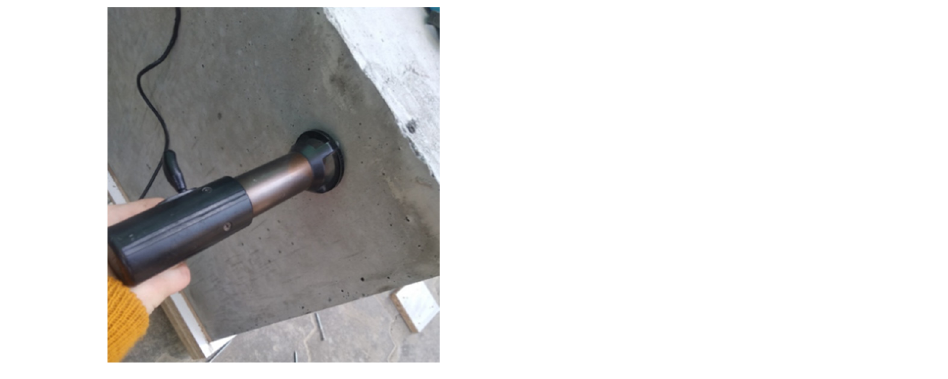
Figure 4. Determination of the strength of concrete in boxes obtained by the IPS-MG 4.01 sclerome- ter.